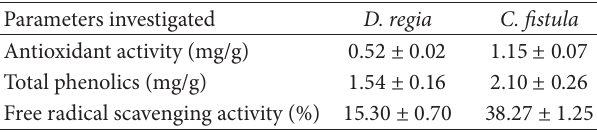
Table 1: Antioxidant activity and total phenolic content of D . regia and C. fistula extracts expressed as gallic acid equivalents